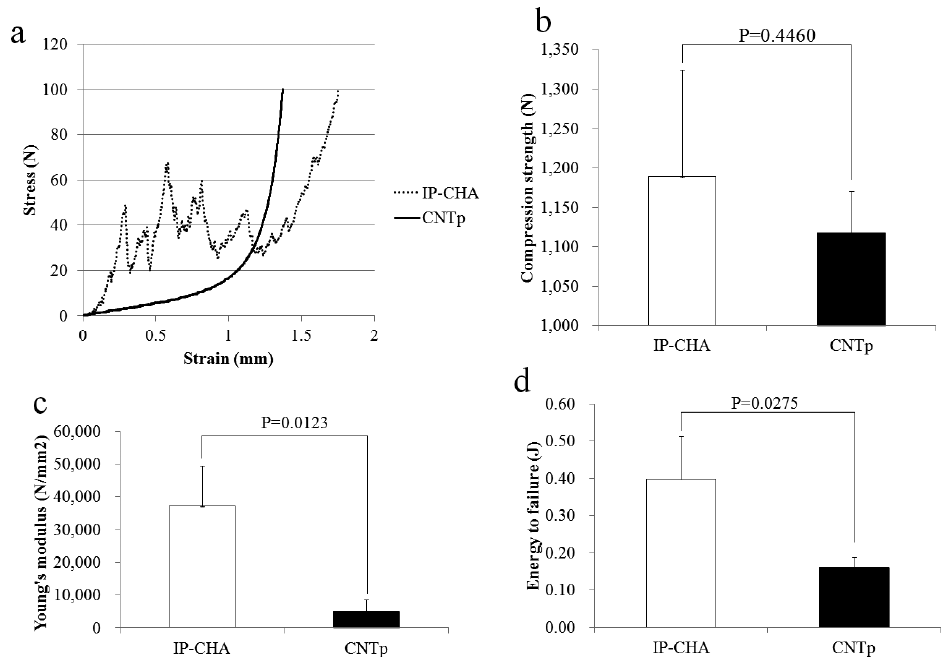
Figure 2. The stress-strain curves ( a ); maximum compressive strength ( b ); Young’s modulus ( c ); and energy to failure ( d ) of the IP-CHA and CNTp. Mean values were compared using Student’s t test ( n = 3).